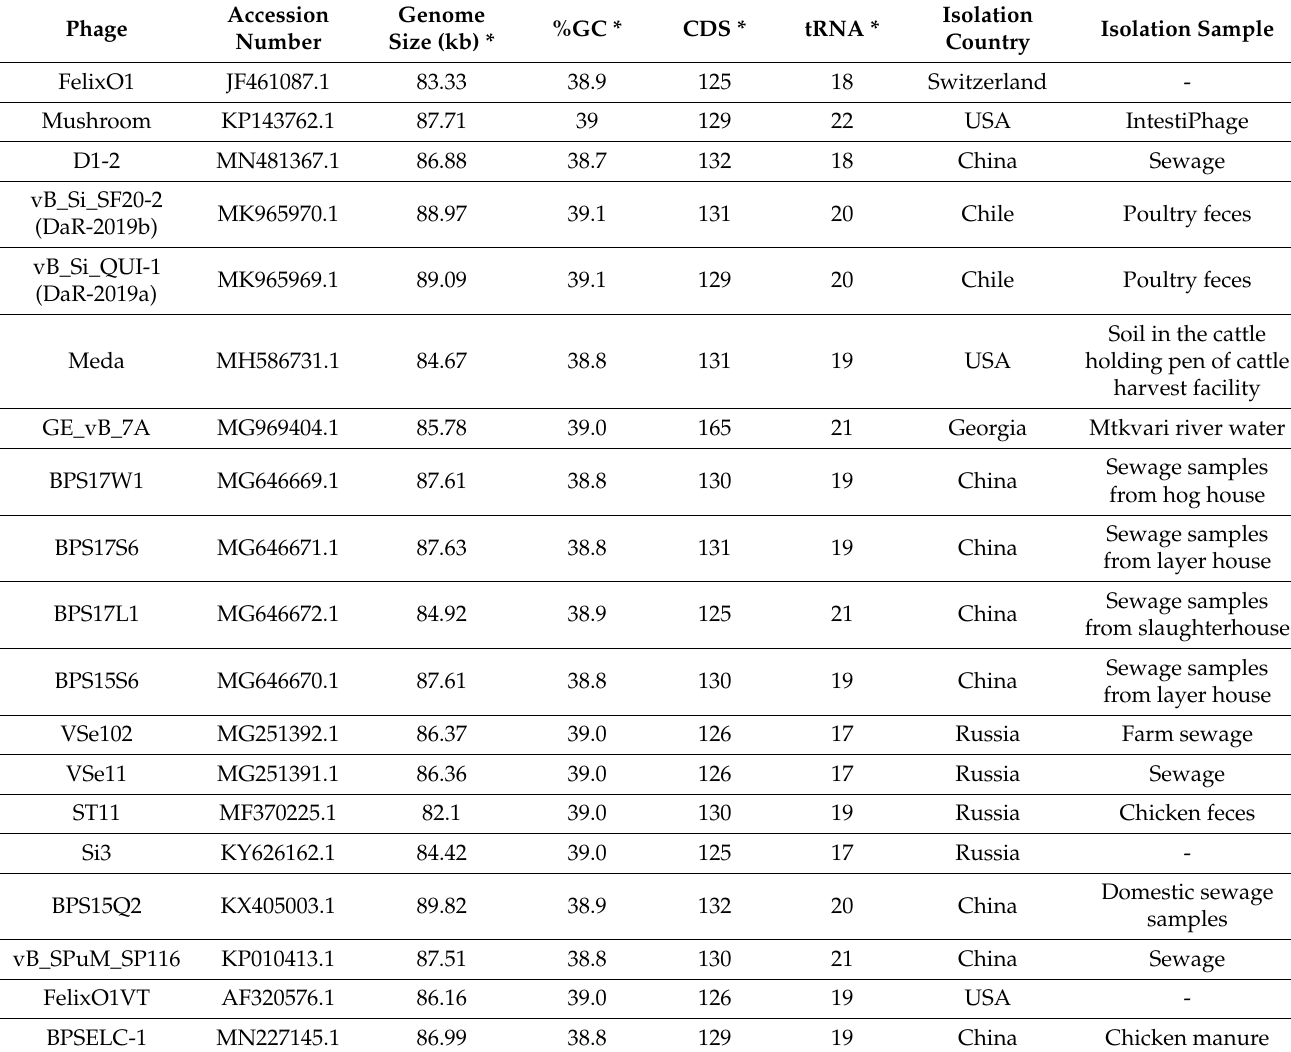
Table 1. Genome information for all genomes selected for comparative